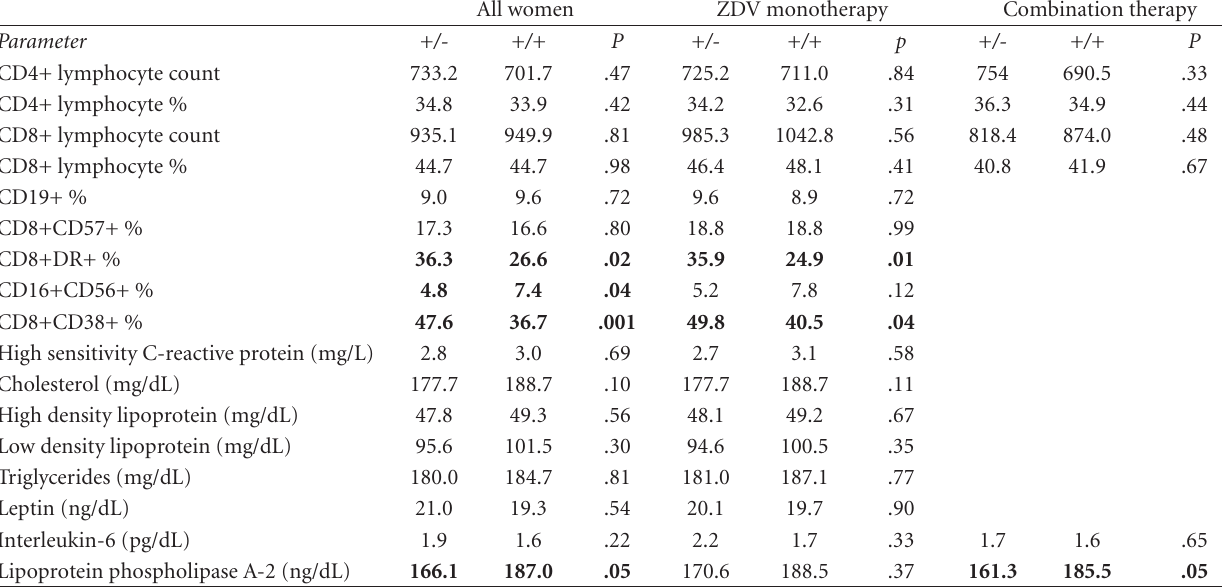
Table 3: Median postpartum laboratory values among women continuing or stopping antiretroviral therapy postpartum according to therapy during